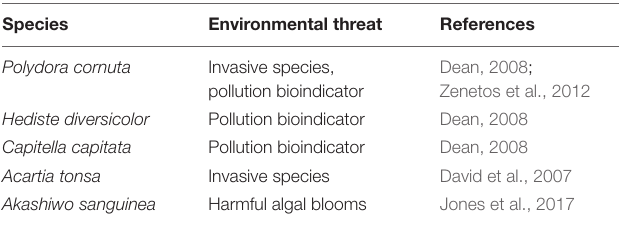
TABLE 2 | Assessment of environmental threats from the species found in Canet-Saint Nazaire